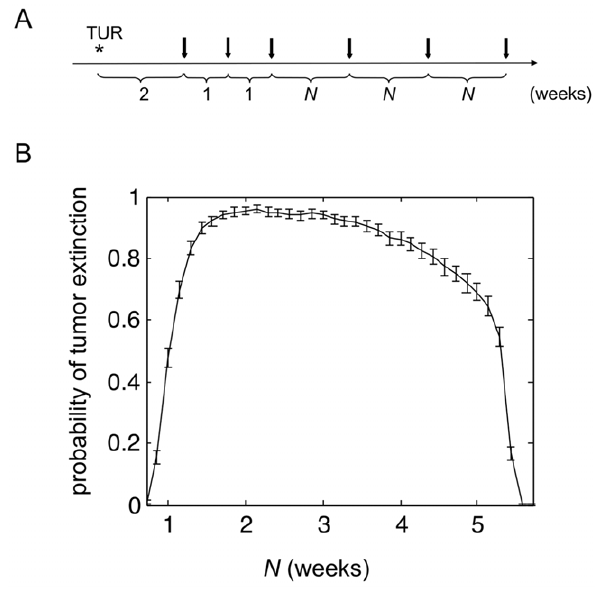
Figure 3. The treatment interval strongly influences the probability of tumor extinction. ( A ) Schematic representation of the modeled surgery time point followed by intravesical treatment time points (arrows). The symbol * indicates the time of transurethral resection (TUR) followed by the 2 weeks interval before BCG therapy starts. Three weekly instillations are given to initiate innate and adaptive immune responses. The time interval between the third through sixth treatment dose was varied and designated by N (as measured in weeks). ( B ) Probability of tumor extinction as a function of N , the inter-instillation interval during the 3 rd – 6 th treatment doses. The dotted line marks the outcome after the recommended interval of N =1